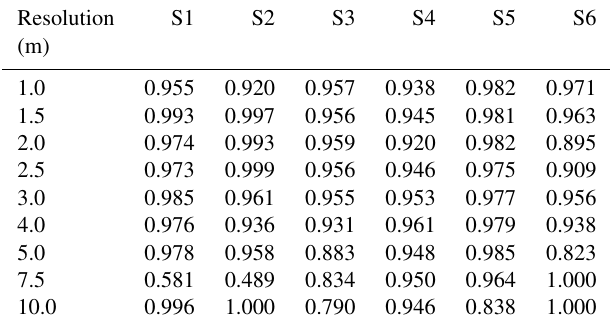
Table A6. Table of sensitivity for sites S1 to S6 (columns) with a Wiener filter, for resolutions varying between 1 and 10m